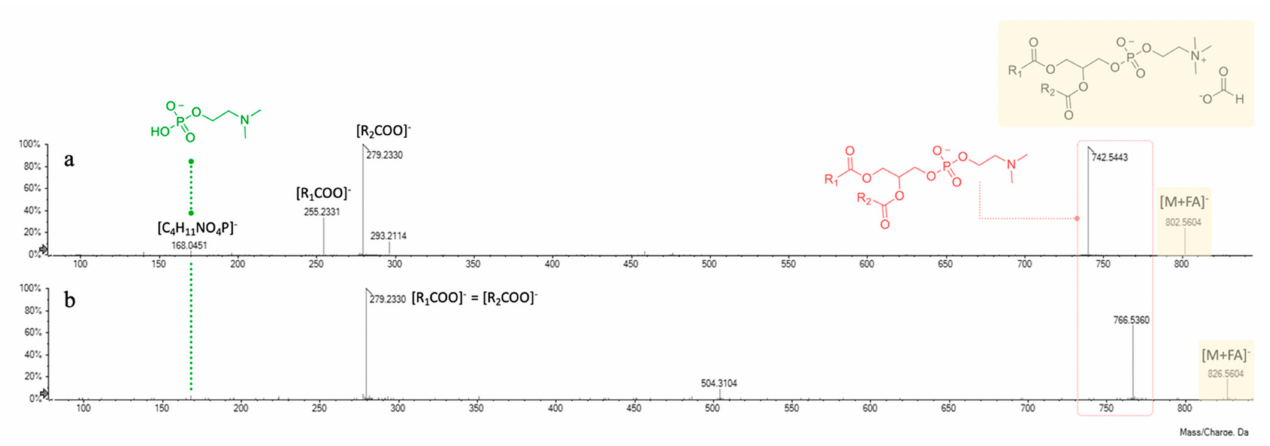
Figure 7. ESI-TOF/MS 2 spectra of compounds 4 ( a ) and 5 ( b ).